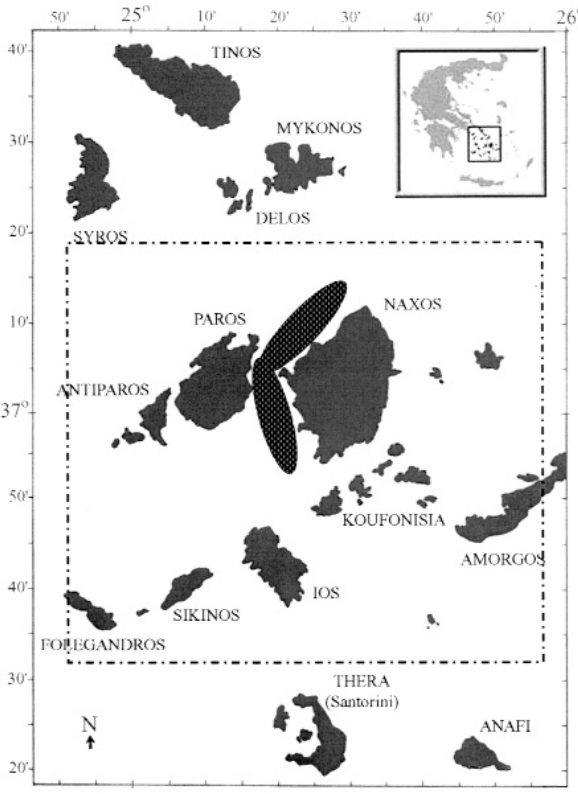
F IG . 1. – Sampling area. The shaded area indicates the fishing grounds sampled by beach-seines, gill nets, trammel nets and long- lines and the box covers the trawl and purse-seine fishing